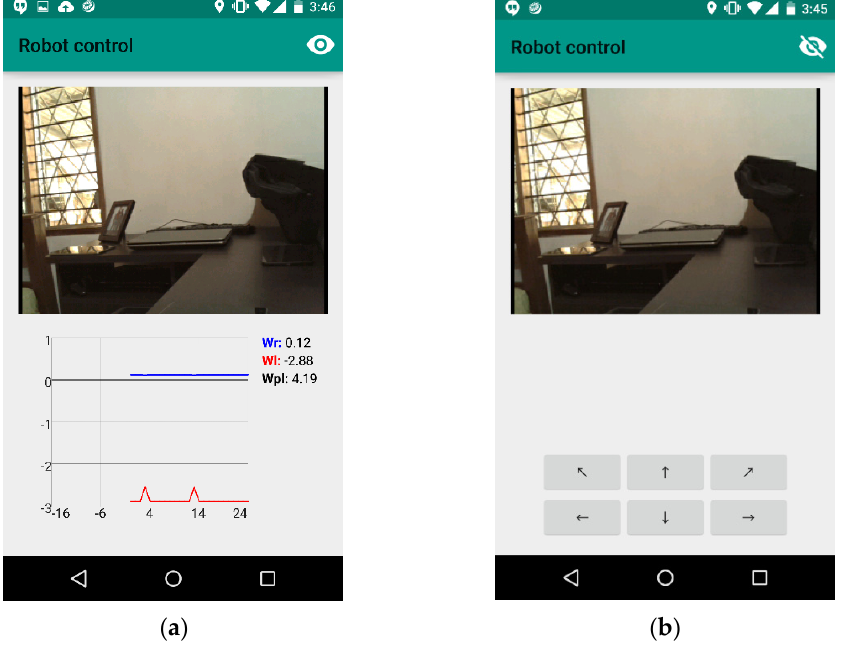
Figure 5. Smartphone app in ( a ) the automatic mode, and ( b ) manual mode.